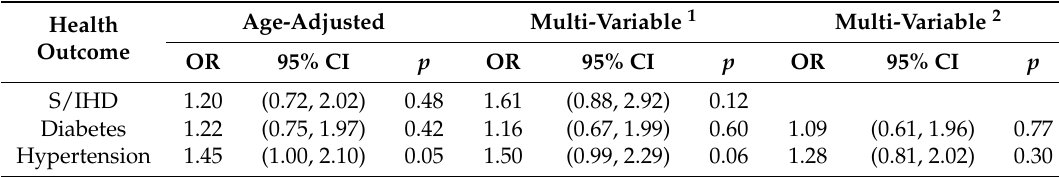
Table 4. Restriction analysis for participants with clinical measurement of